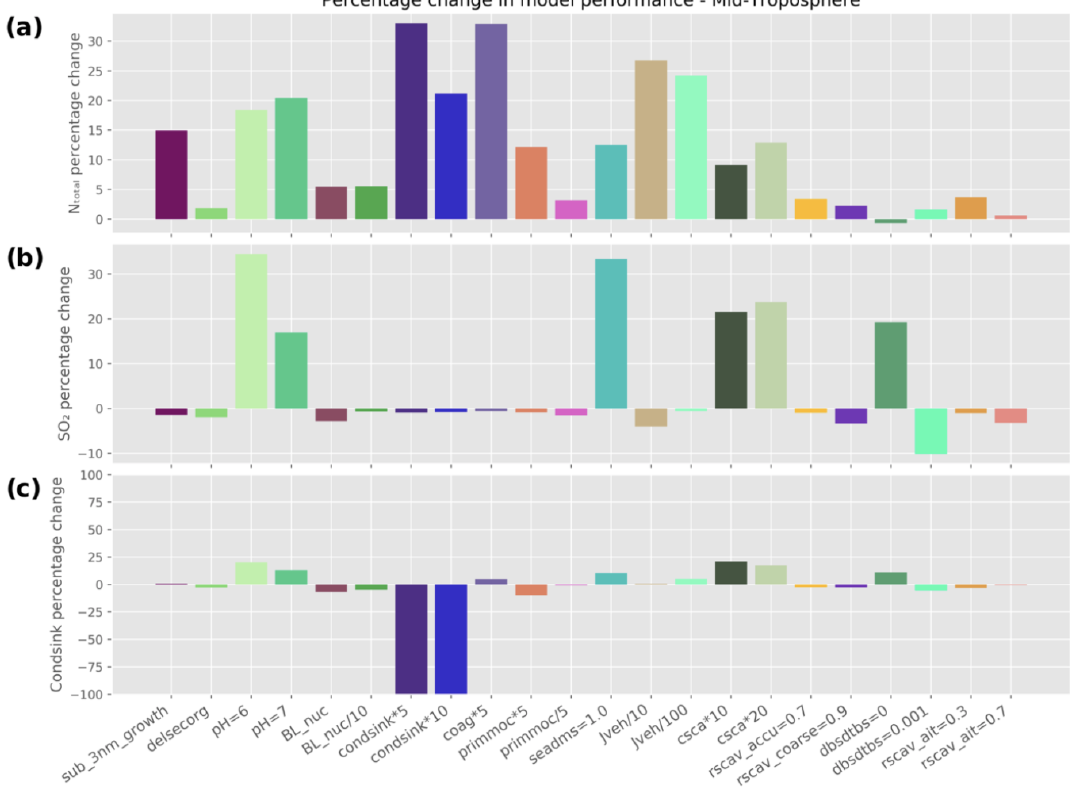
Figure A8. Percentage change in model performance for the different perturbation experiments in the mid troposphere (4km < altitude < 8km) with respect to (a) N Total , (b) SO 2 , and (c) condensation